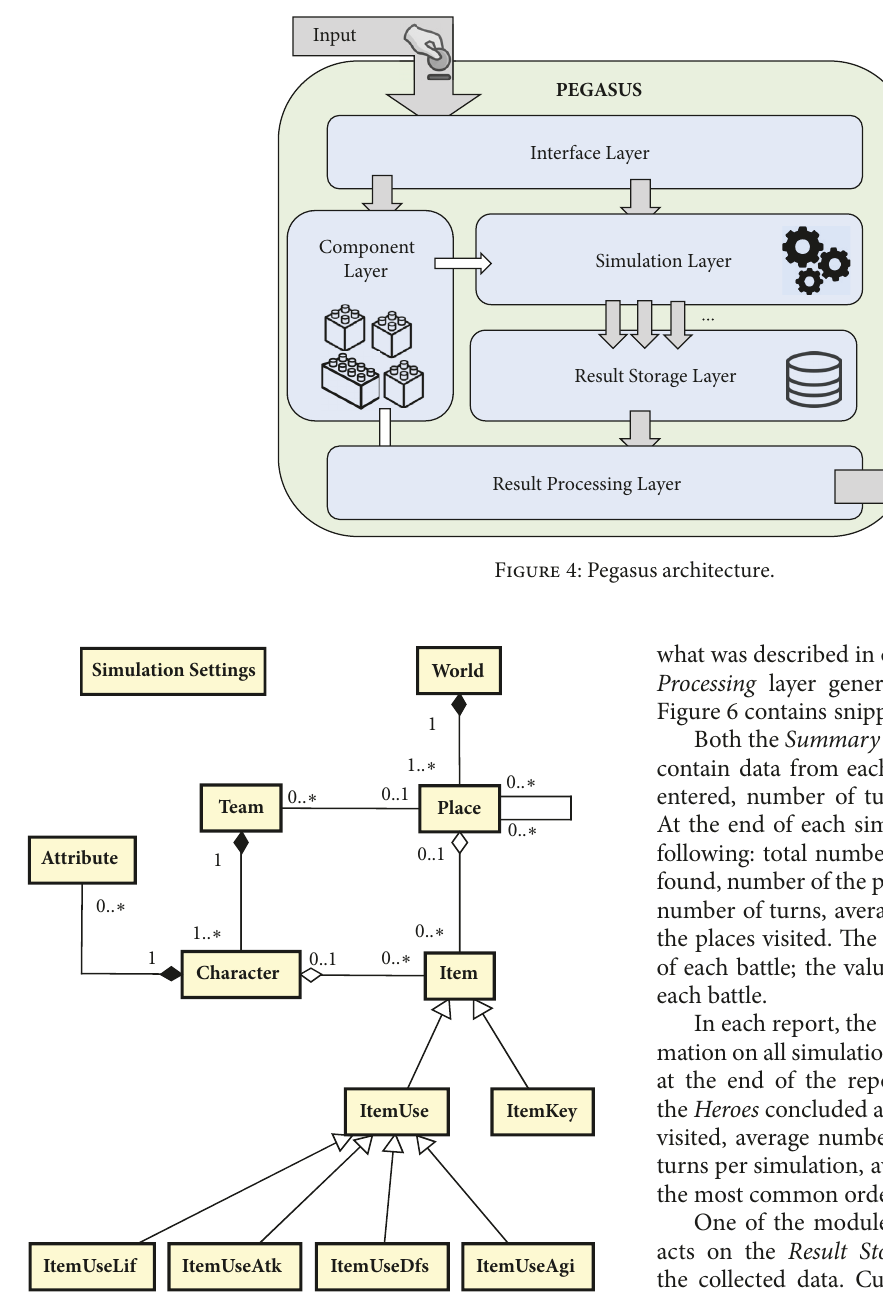
Figure 5: Class diagram for Input